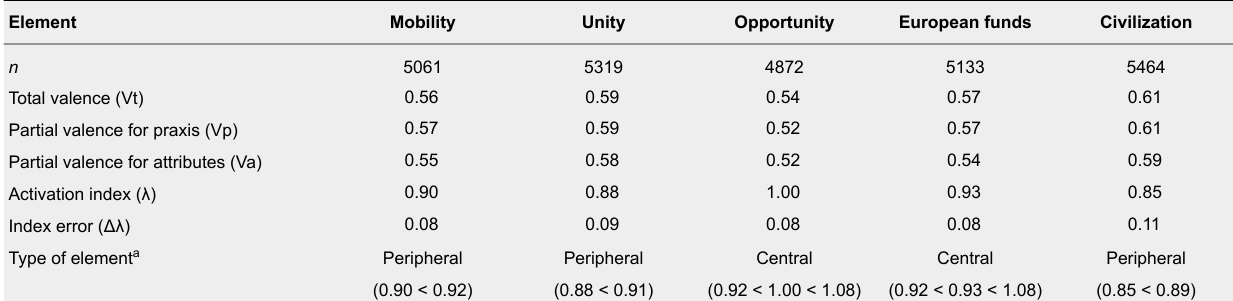
Total and Partial Valences, Activation Index and Index Errors for Each of the Five Core Elements (N = 106